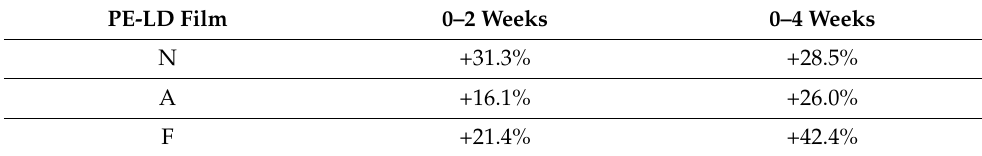
Table 3. Variations in the Carbonyl Index during the ageing